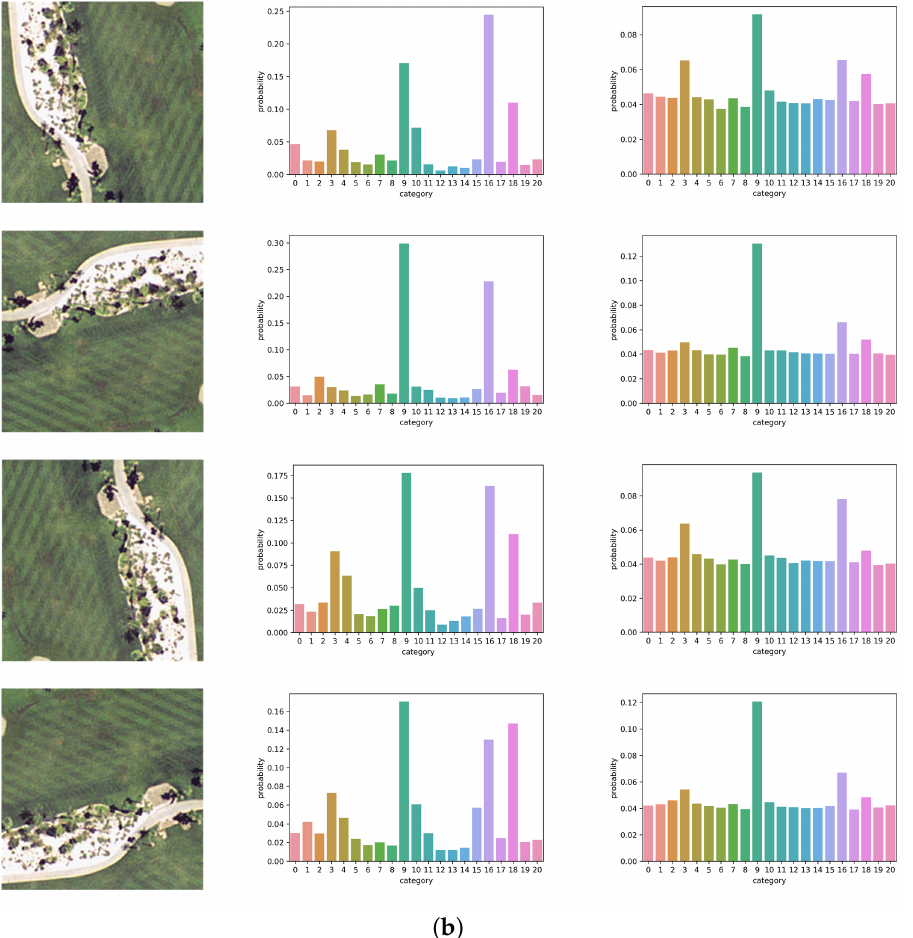
Figure 13. Softmax outputs with temperature T = 5.0 of examples with different orientations. The first column shows test examples and their corresponding rotated versions. The second column shows the softmax output of baseline CNN with T = 5. The last column shows the softmax output of RIR-net with T = 5. ( a ) Example #4 (building category), which appears similar to the categories of #6 (dense residential), #12 (medium residential), and #13 (mobile home park); ( b ) Example of #9 (golf course), which appears similar to the categories of #3 (beach), #16 (river), and #18 (sparse